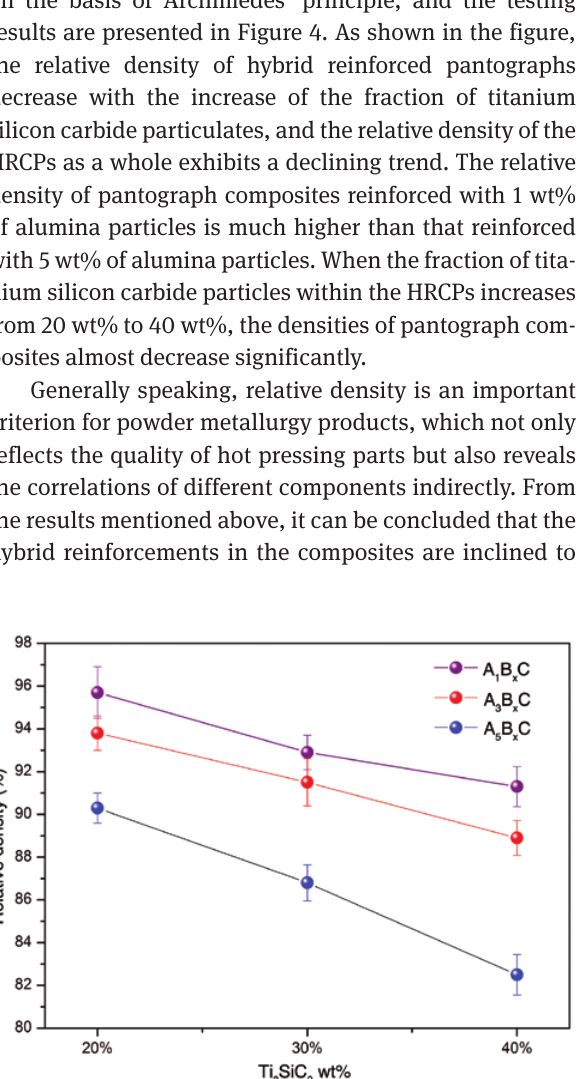
Figure 6: Interfacial bonding of HRCP